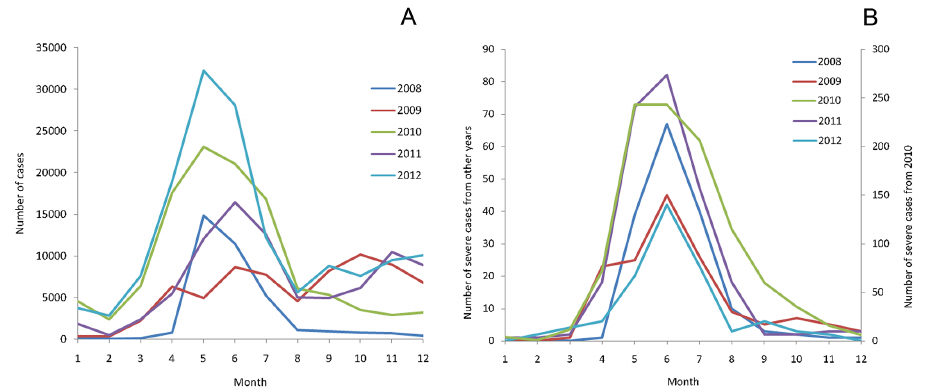
Fig 2. The monthly distribution of the number of mild cases (A) and severe cases (B) during 2008 – 2012.